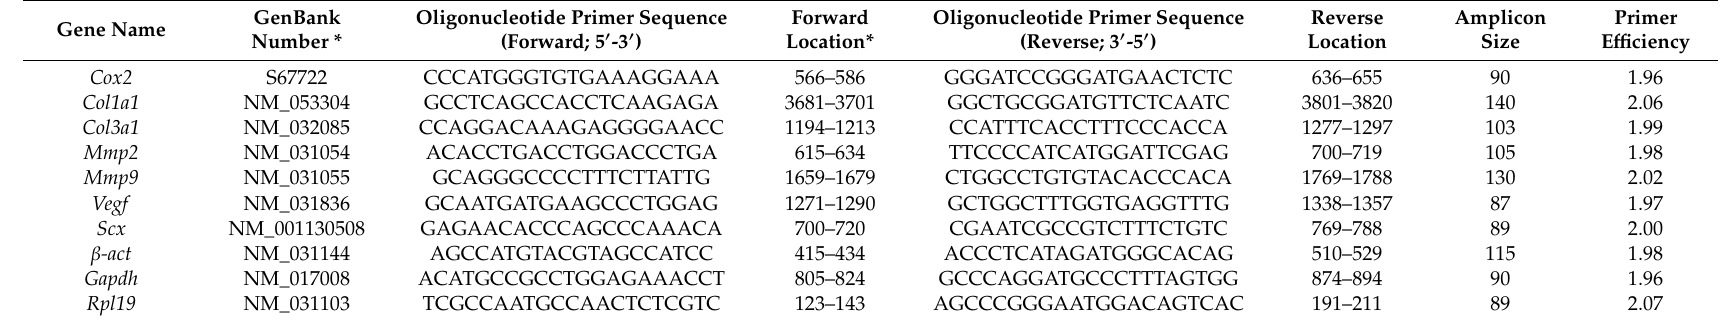
Table 2. Oligonucleotide Primer Sequences used for